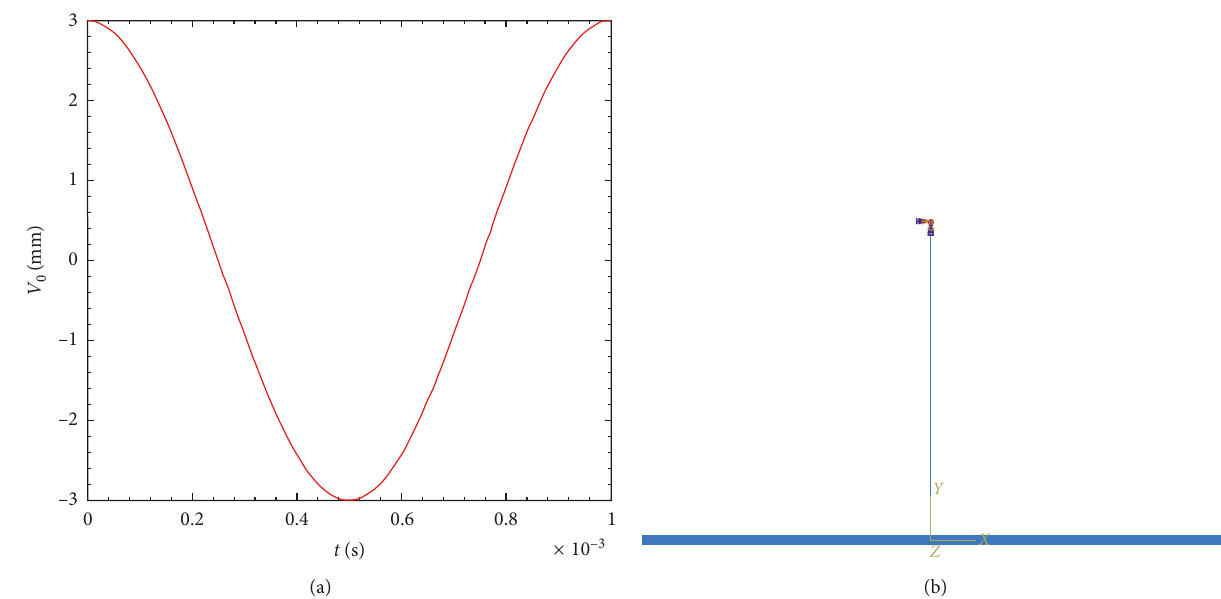
Figure 2: A cycle of cosine load (a) and the finite element of the model